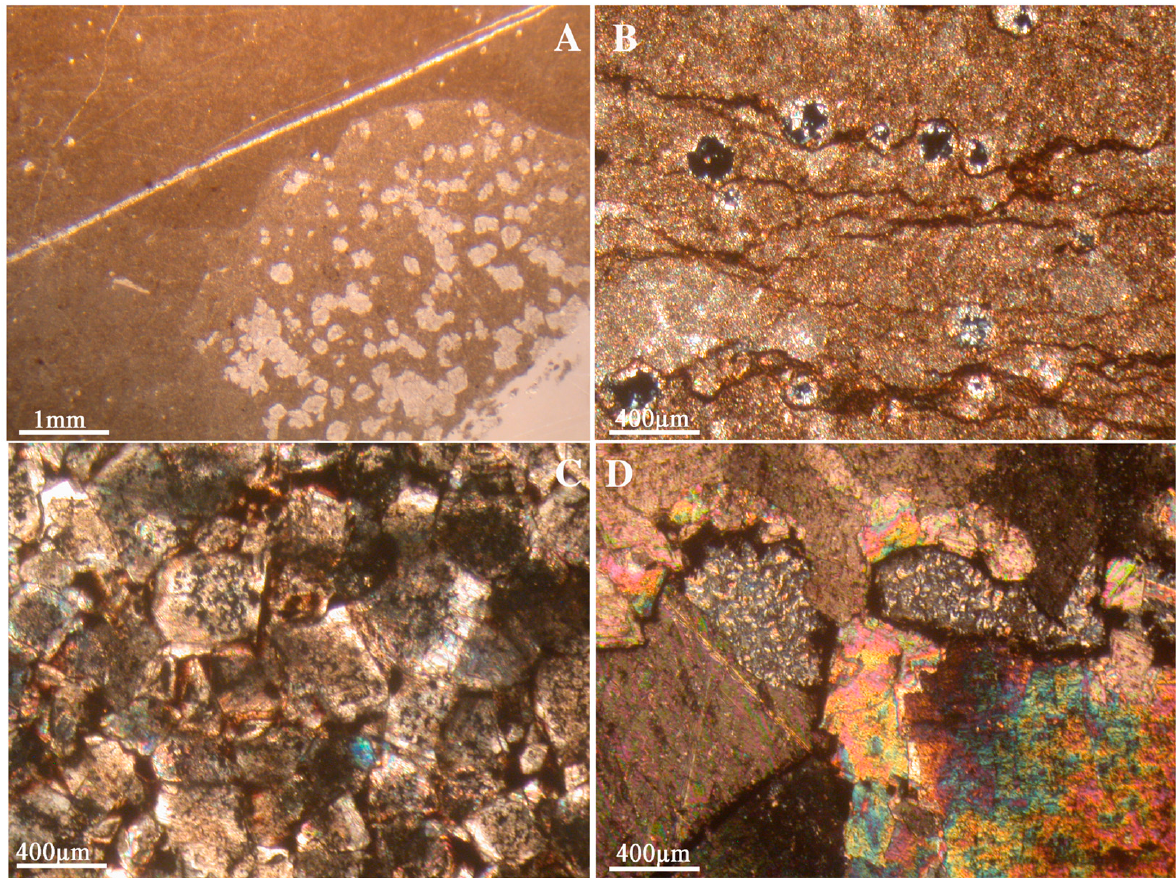
Figure 4. Photomicrographs illustrating characteristics of silicate mineral content. ( A ) Litho-clast “right most part of the photo” embedded by mega-quartz grains. ( B ) Micro-organisms of spherical shapes of Radiolaria, the chalcedony micro-crystalline quartz partially filled the pore spaces of Radiolaria. ( C ) Mega-quartz grains in places replaced by dolomite minerals, see the strong relief and inclusions of quartz in the core of some grains. ( D ) Late diagenesis dolomite cements “D b ” replaced the microcrystalline quartz.